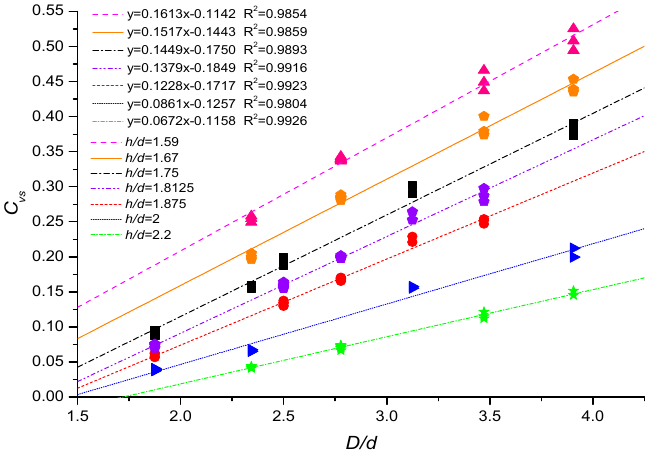
Figure 8. Relations between vertical suction force coefficients and Reynolds numbers.